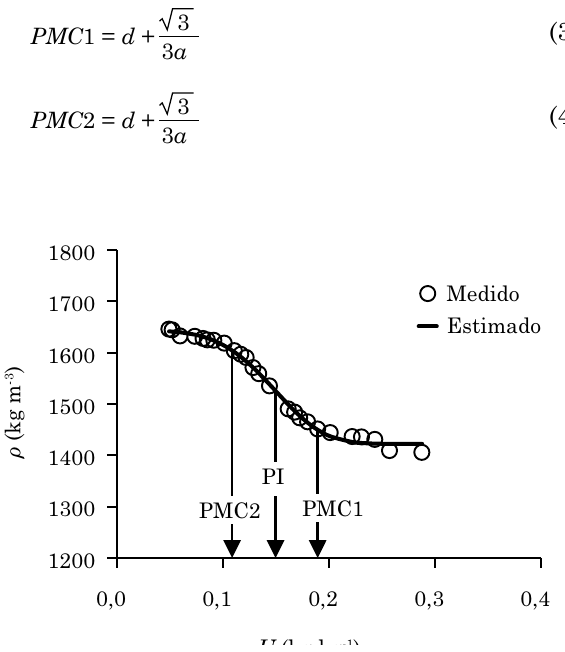
Figura 1. Pontos observados de densidade do solo ( ρ ) versus conteúdo gravimétrico de água ( U ), com indicação aproximada dos pontos de máxima curvatura ( PMC1 e PMC2 ) e do ponto de inflexão ( PI